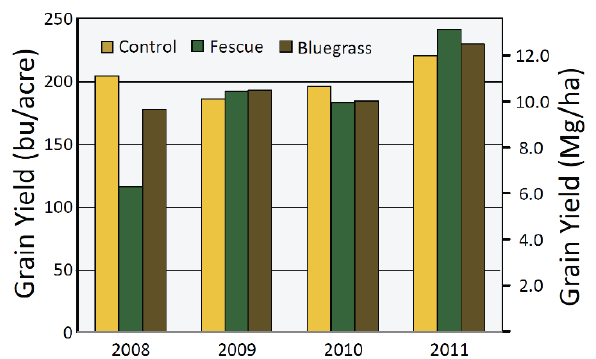
Figure 5. Grain yield in four successive growing seasons for maize grown conventionally (Control) and with perennial groundcover (red fescue, Kentucky bluegrass) in central Iowa, USA.